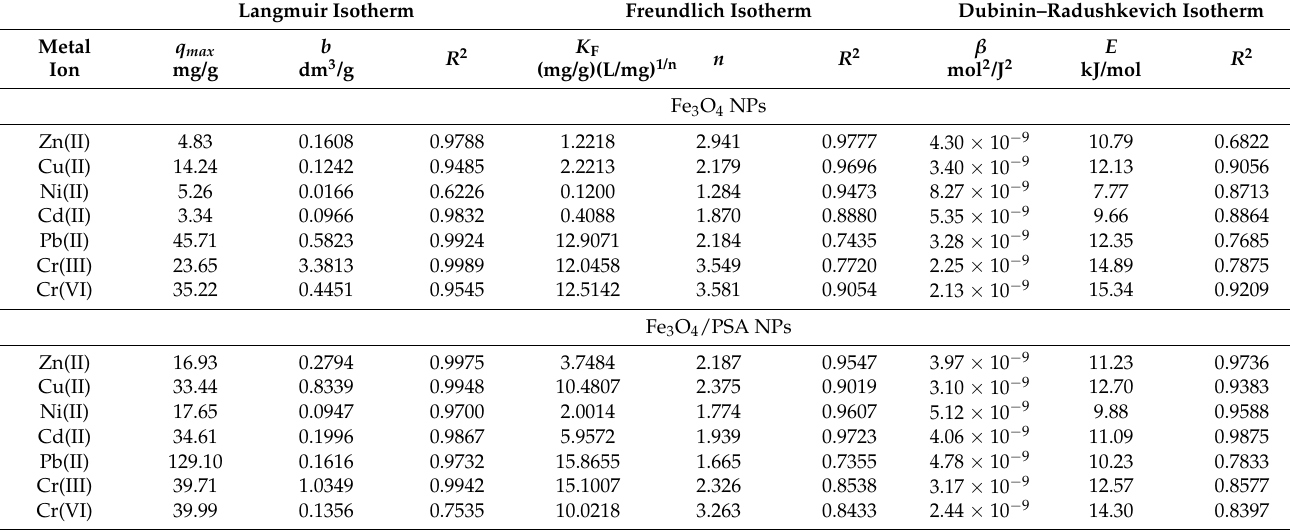
Table 1. Parameters of applied model